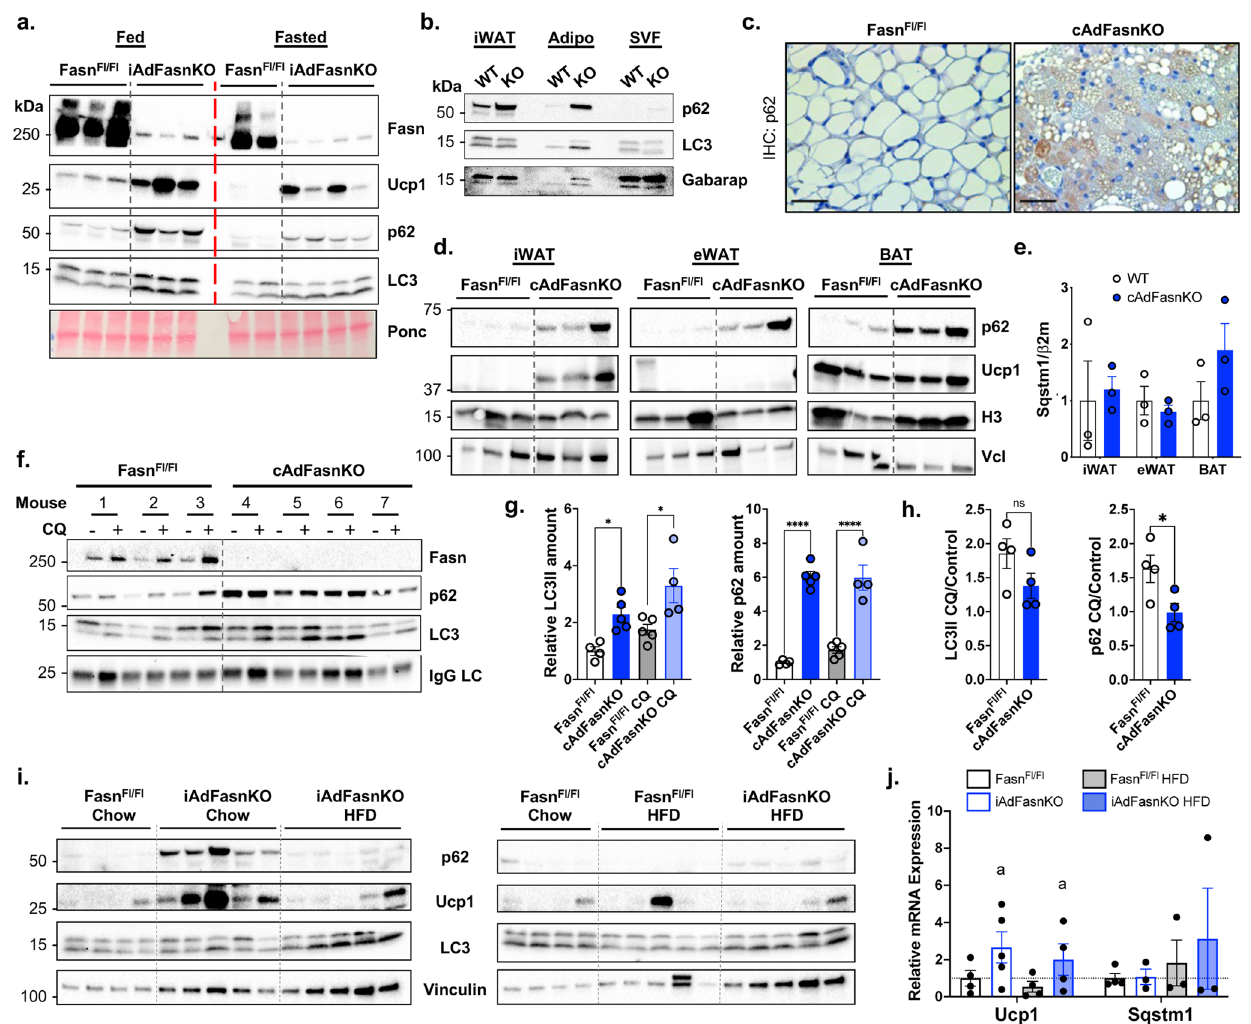
Fig. 4 | Adipocyte Fasn de fi ciency impairs autophagy and induces accumula- tion of p62 protein in vivo. a Western blot of subcutaneous white adipose tissue (WAT)fromFasn Fl/Fl andinducibleAdFasnKO(iAdFasnKO)miceunderfedand24h- fasted conditions. Ponceau (Ponc) provided for loading control. n =3 mice (fed, Fasn Fl/Fl and iAdFasnKO), n =2 mice (fasted, Fasn Fl/Fl ), n =4 mice (fasted, iAd- FasnKO). b Western blot of pooled ( n =4 mice/group) subcutaneous WAT (iWAT) fromFasn Fl/Fl (WT)andiAdFasnKO (KO)miceseparatedintoadipocyte(Adipo)and stromalvascularfractions(SVF). c Immunohistochemicalstainingofp62iniWATof Fasn Fl/Fl and iAdFasnKO mice; scale bar=25 µ m. Representative image from n =4 mice. d p62 Western blot of adipose tissue depots from Fasn Fl/Fl and cAdFasnKO mice. Histone H3 (H3) and vinculin (Vcl) provided as loading controls. eWAT = epididymal adipose tissue, BAT=brown adipose tissue. n =3 mice. e qPCR com- paringp62( Sqstm1 )mRNAexpressionacrossadiposetissuedepots. n =3mice. f Ex vivo autophagy fl ux assay in subcutaneous WAT explants harvested from Fasn Fl/Fl